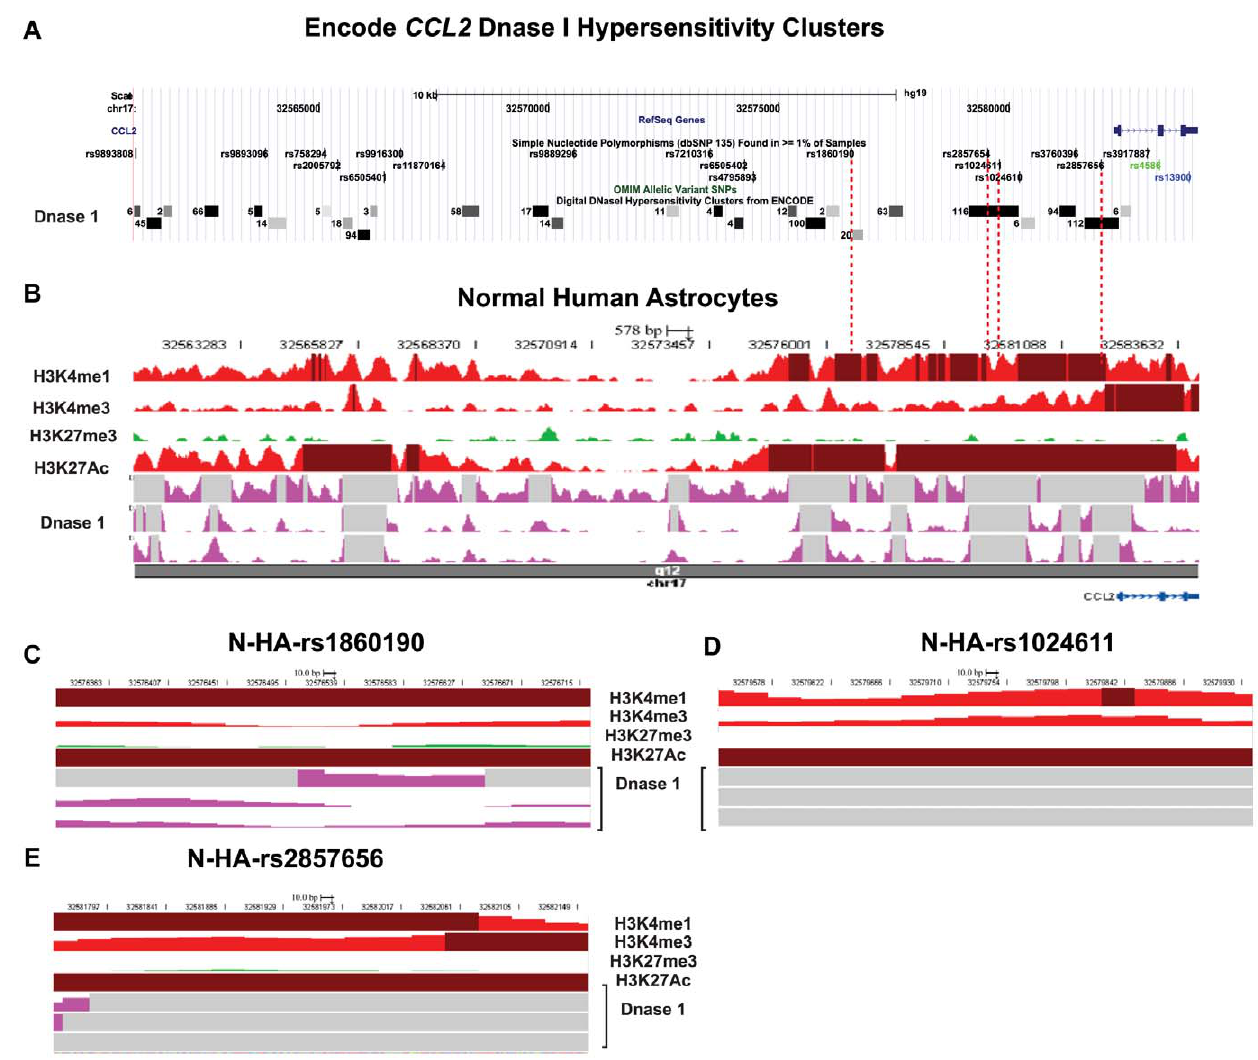
Figure 4. Epigenetic features associated with CCL2 locus in cell lines and normal human astrocytes. (A–B) Relative location of the SNPs linked to rs13900 (highlighted by red dashed lines) to Encode DNase 1 hypersensitivity sites in the CCL2 locus as depicted in the UCSC genome browser (Panel A) and histone and DNase 1 tracks in the human epigenome browser (Panel B). Nucleotide numbering is according to hg19. The DNase 1 sites in panel A are depicted as boxes. The shade of the box is proportional to the signal strength detected with darker shaded boxes representing increased sensitivity to digestion. The numbers next to the boxes indicate the numbers of cell lines in which the region is hypersensitive. Panel B shows a wiggle plot depicting relative enrichment of the histone activation markers (H3K4me1, H3K4me3, H3K27Ac, indicated in red) and histone repressive marks (H3K27me3, indicated in green) across the CCL2 locus. The heatmap track was configured to set the threshold for the peaks at 20 and values higher than the threshold are shown in brown. Also shown are the tracks for DNAse 1 sensitivity (purple tracks). Regions in gray indicate the regions with higher peaks than the set threshold. (C–E) Heatmaps showing localized histone tracks in CCL2 5 9 -flanking regions that overlap with the linked polymorphisms. A 500 bp region that spans the indicated polymorphism is shown. No separate panel is shown for rs2857654 due to its proximity to rs1024611. Other details are as in Panel B. The source of the data used for the generation of the DNase 1 tracks is from the Geo accession number GSE29692 (DNaseI Hypersensitivity by Digital DNaseI from ENCODE/University of Washington; public release on June 03, 2011) and for the histone tracks is Geo Accession numbers GSM733763 (H3K27Ac), GSM733729 (H3K27Me), GSM733747 (H3K4me3), and GSM733710 (H3K4me1) deposited by the Bernstein Lab at the Broad Institute (Histone Modifications by ChIP-seq from ENCODE/Broad Institute; public release on Jun 2, 2011). The tracks were generated using ENCODE database and UCSC genome browser [63,64] and Human epigenome browser [65].